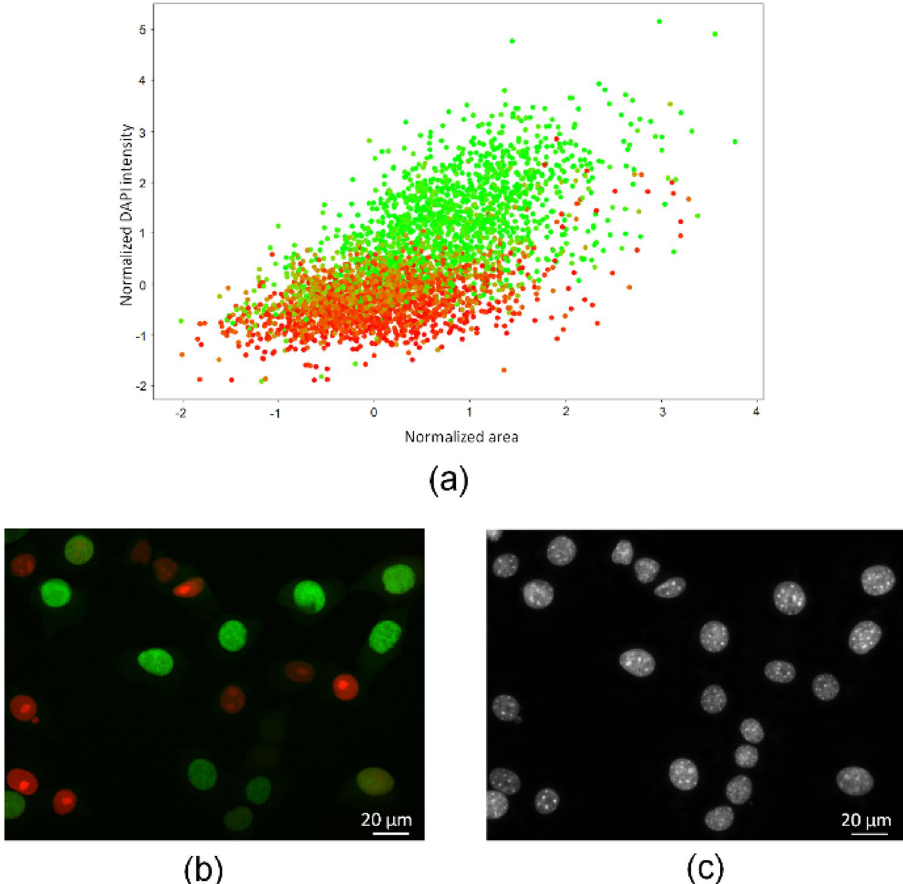
Figure 4. Comparison between Fucci2 labels and DAPI features. Representation of each nucleus in the 2D space (normalized area, normalized DAPI intensity). Each point is colored with the following intensities (R, G, , µ g , 0 µ r B) = k k (cid:31) (cid:30)